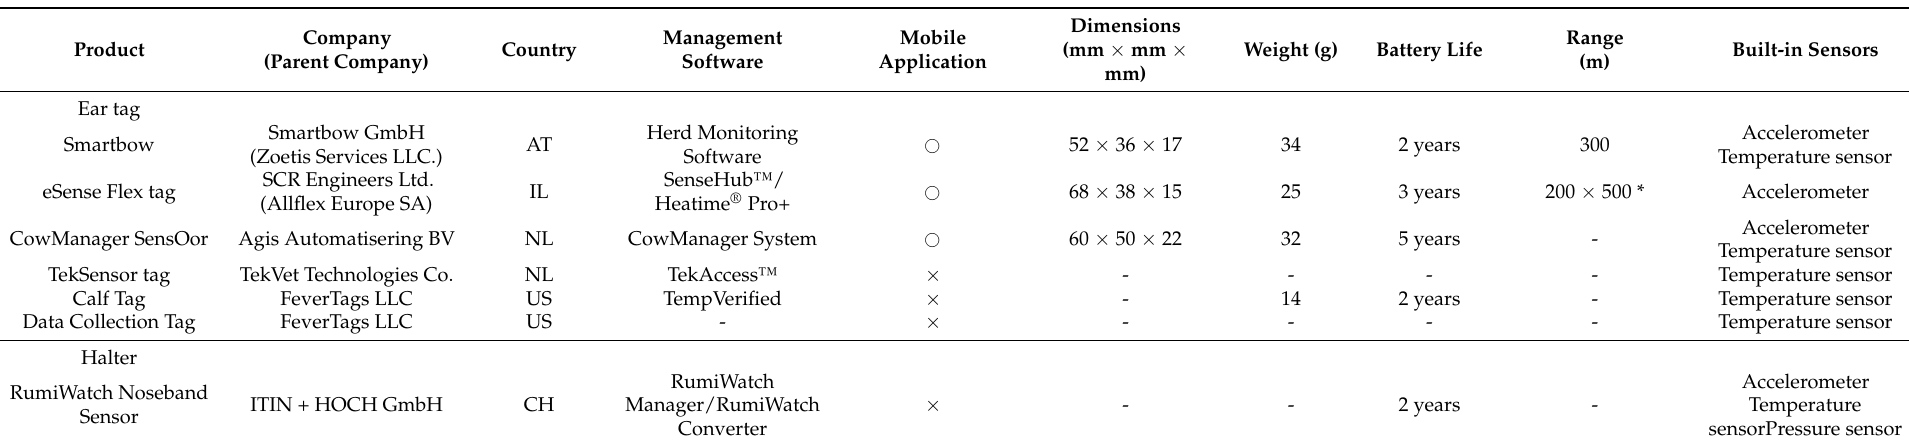
Table 1. Information about currently available ear-tag and halter type sensor.